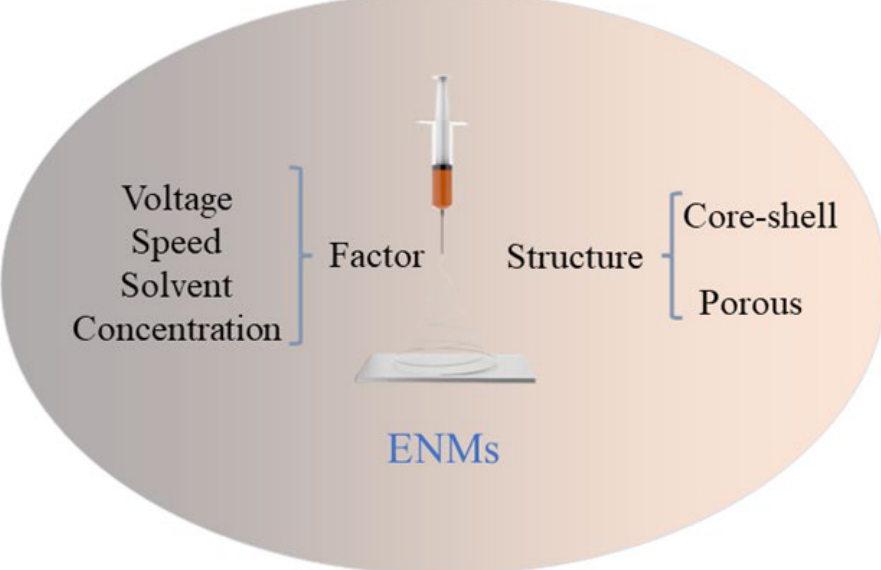
Figure 1. Preparation and structure of ENMs.